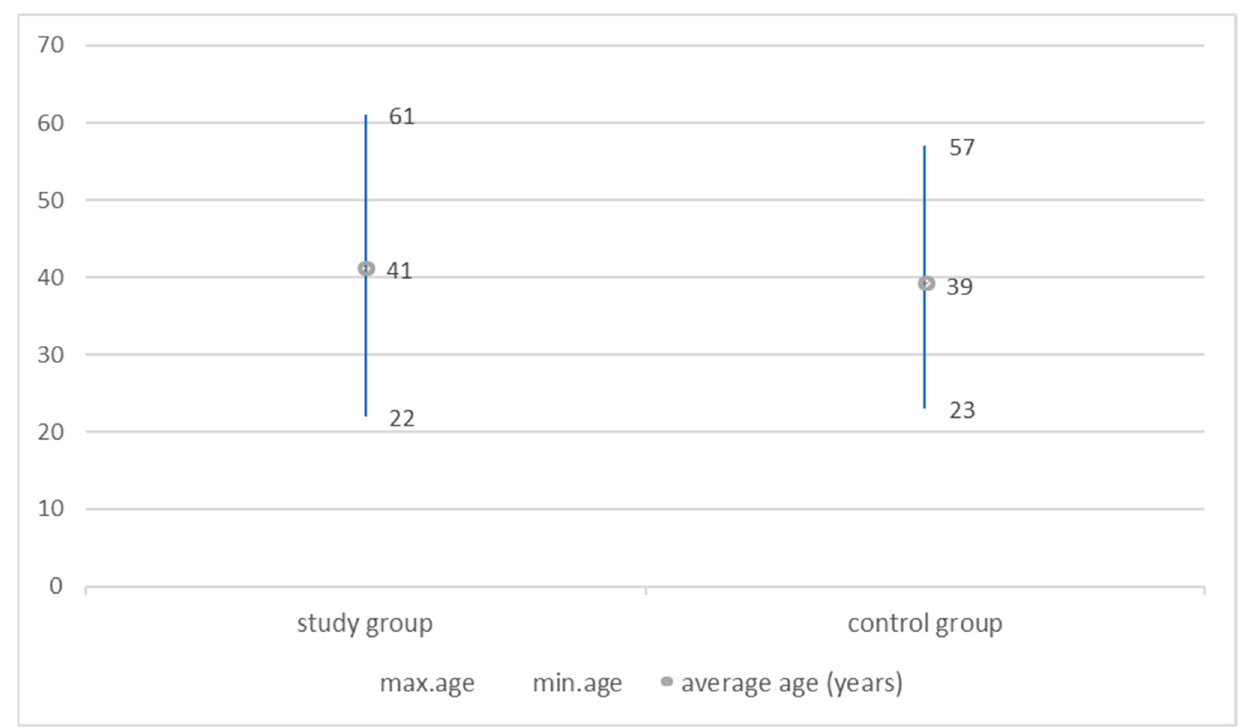
Figure 2. Comparison of groups by age. There was no statistically significant difference in age between the groups ( p > 0.05). ( p > 0.2) and Shapiro-Wilk ( p > 0.07) Tests are